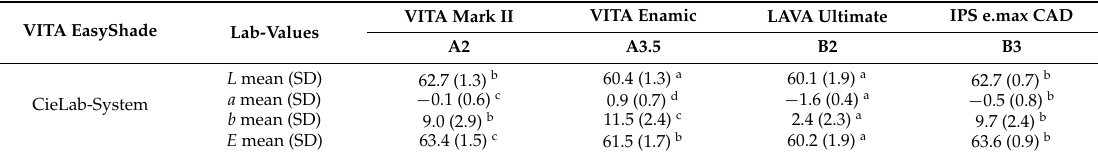
Table 2. Descriptive statistics of the CieLab-System parameters (mean, standard deviation (SD) of veneering materials together with VITA EasyShade